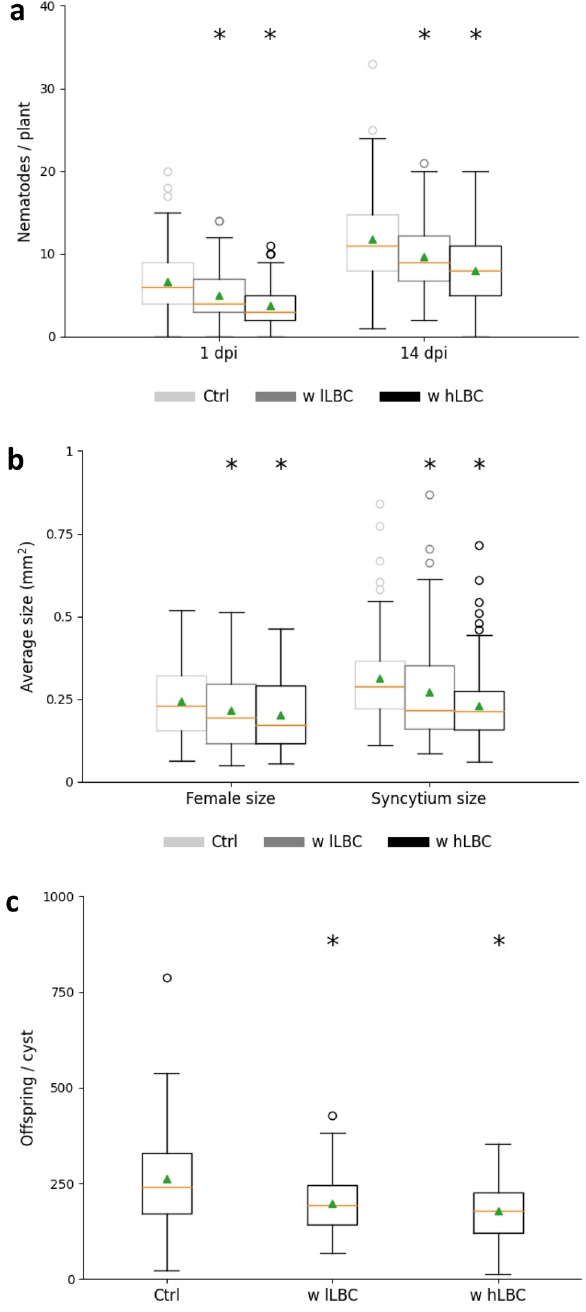
Figure 8. Arabidopsis thaliana root parasitism of Heterodera schachtii 2nd generation nematodes originating from Bacillus firmus colonized cysts. Average number of nematodes per plant at 1 dpi and 14 dpi ( a ); Average size of female and syncytium at 28 dpi ( b ); Average number of eggs and juveniles per cyst at 35 dpi ( c ). w hLBC with high number of living bacterial cells; w lLBC with low number of living bacterial cells; dpi days post inoculation Results are expressed as the mean (orange line) and median (green triangle) ± standard error of three independent biological replicates (n ≥ 97). Data are statistically analysed using Dunn’s Method. Asterisk (*) indicate statistically significant differences compared with the control ( p <